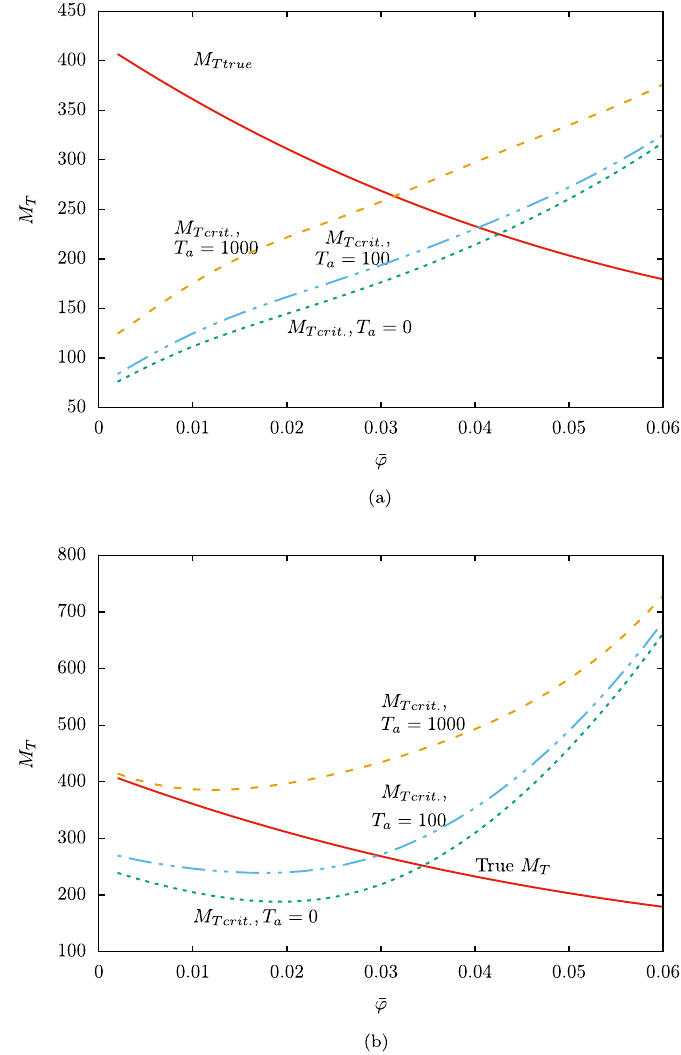
Figure 4: The true and critical temperature Marangoni numbers for DW/cupric oxide nano fl uid with = d 30 nm p , = T Δ 2°K for average volume fractions ranging from 0.01 to 0.06. Stability boundary curves for the temperature Marangoni number are calculated based on ( a ) Model I and ( b ) Model II, using the thermal conductivity and dynamic viscosity constitutive functions proposed by Khanafer and